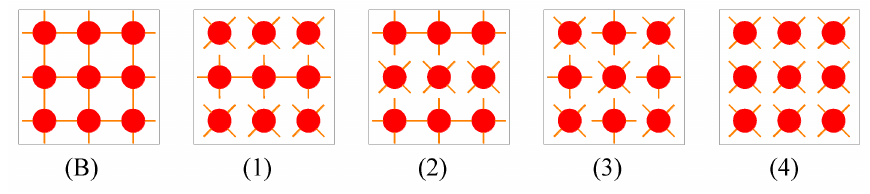
Figure 11. Fin layouts considered in [54]. (B) baseline layout, (1) (2) (3) (4) different fin layouts.